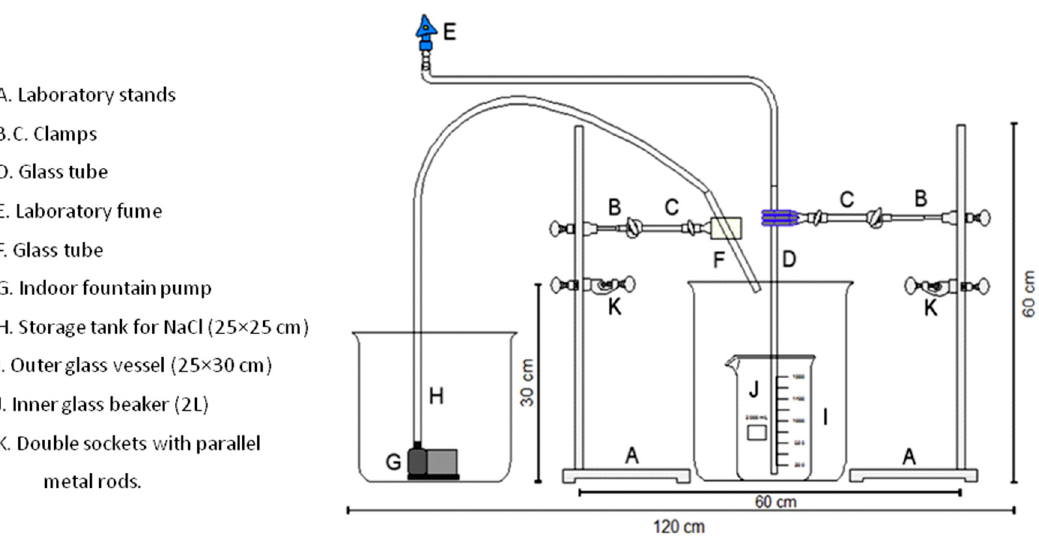
Figure 8. Scheme of the experimental setup for the air-induced overflow AIO method (taken from reference [50] with permission of Elsevier).